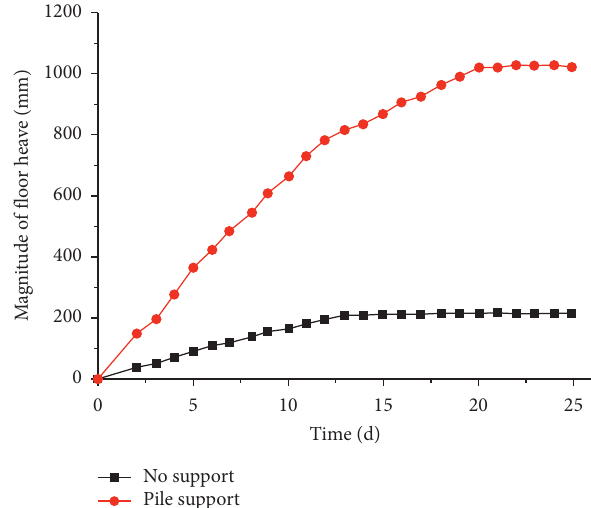
Figure 10: The law of floor heave changing with time.